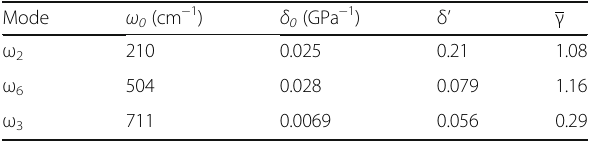
Table 3 Calculated pressure-dependent parameters of Ti 3 C 2 T x . γ refers to the averaged Grüneisen parameters that were calculated using equation γ = − dln ω /(3 dlnr